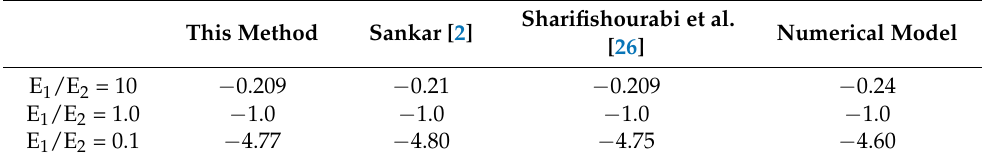
Table 2. Validation of E-FGM stress distribution.